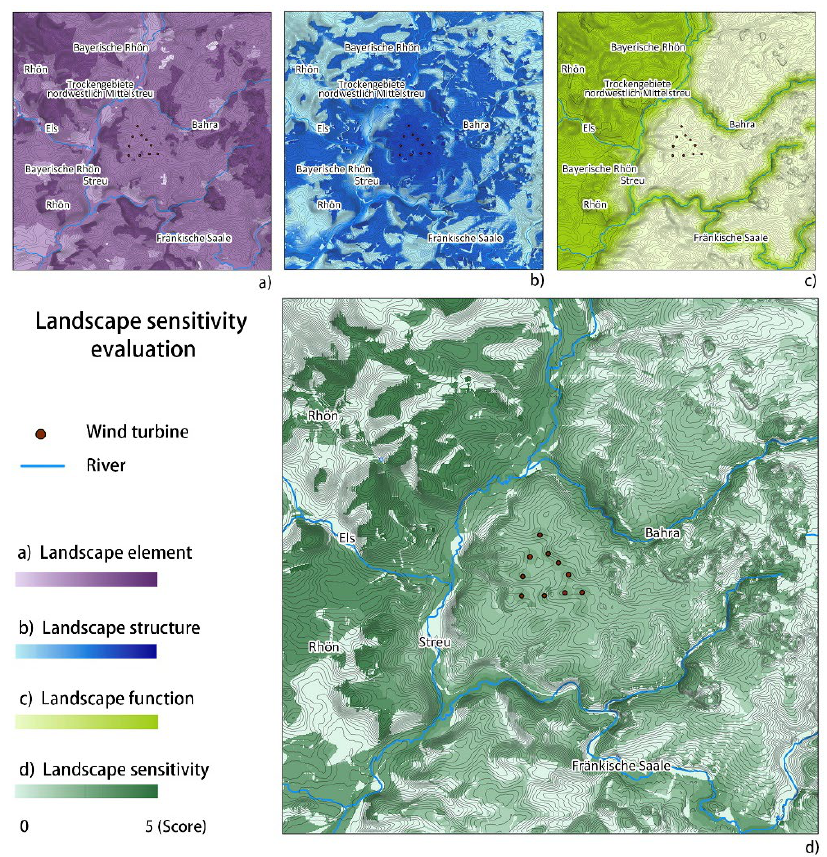
Figure 4. ( a – d ). Results of landscape sensitivity evaluation.